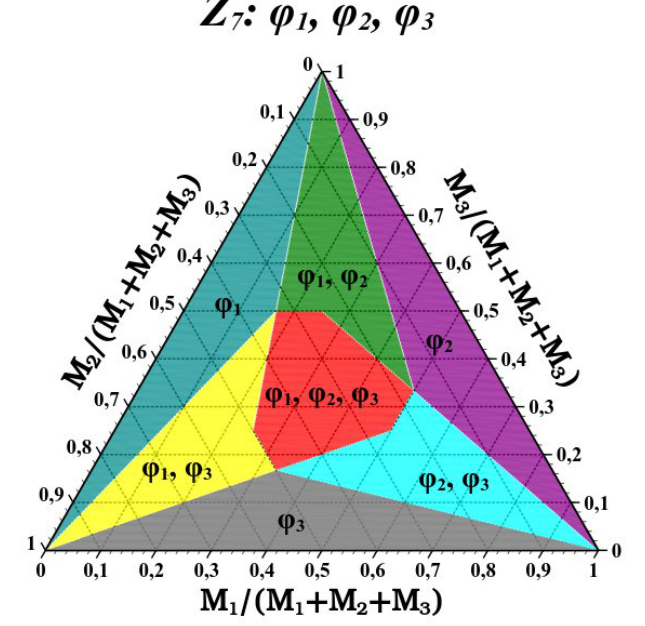
Figure 1 . A ternary plot of the stability regions for the Z 7 model. For each region, the fields that are stable within it are explicitly written. The three-component dark matter scenario that is of interest to us is realized in the central (red)